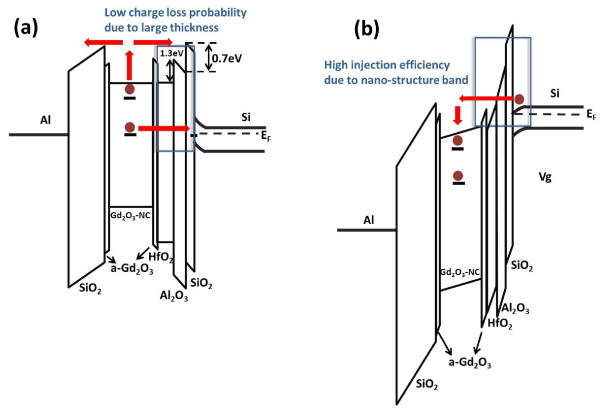
The band diagrams of Gd2O3-NC memories with nanostructure at (a) retention and (b) programming states. The bandgaps of HfO2 and Al2O3 are assumed to be 6.1 and 8.7 eV, respectively [22,23]. The charge loss paths of shallow traps and deep traps are pointed out by arrow signs in (a); the charge injection paths when applying gate voltage is drawn by arrow signs in (b).